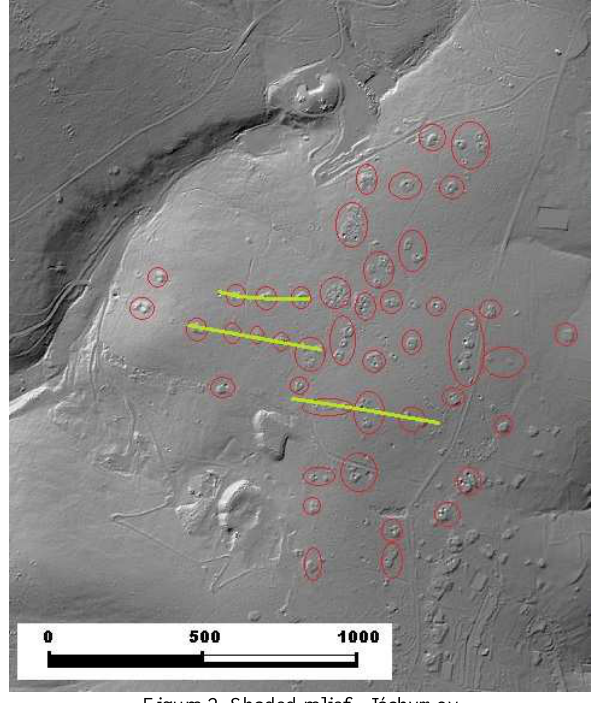
Figure 2. Shaded relief -